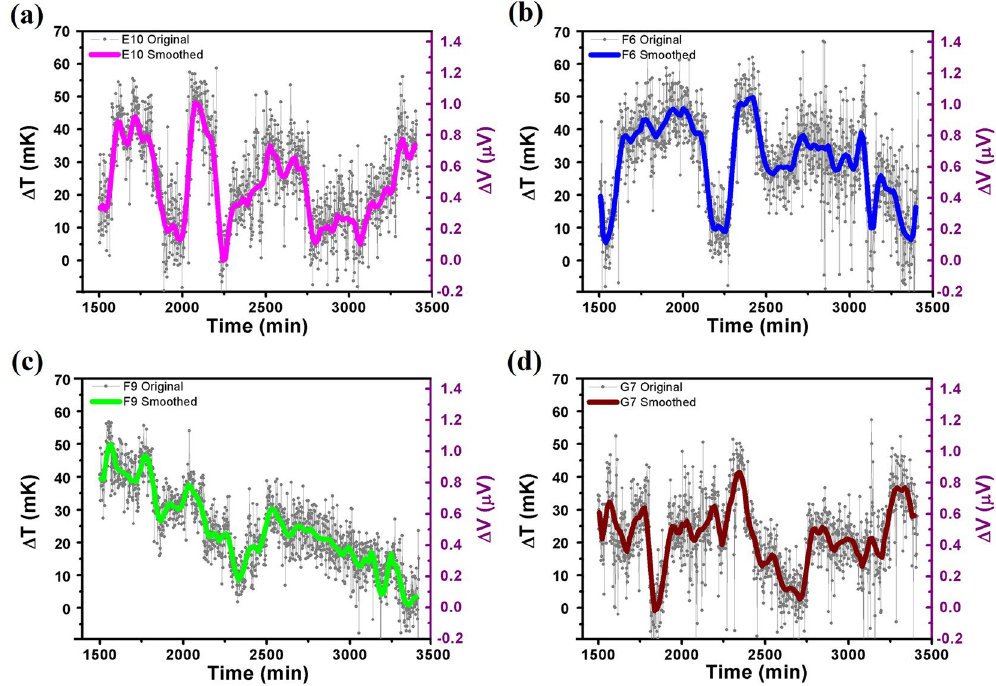
Figure 7. Typical cases of increments of local temperature in Testing Zones recorded with 4 Pd/Cr micro- TFTCs at 32 °C. ( a – d ) Measurement data of different Testing Zones taken from Pd/Cr micro-TFTC sensors of E10, F6, F9 and G7, respectively. For the data plotted here, background temperature has been deducted. The grey symbols and lines represent the original data, and the thick lines present the average values of each set of data. Recorded increments of local temperature in Testing Zones are within 60